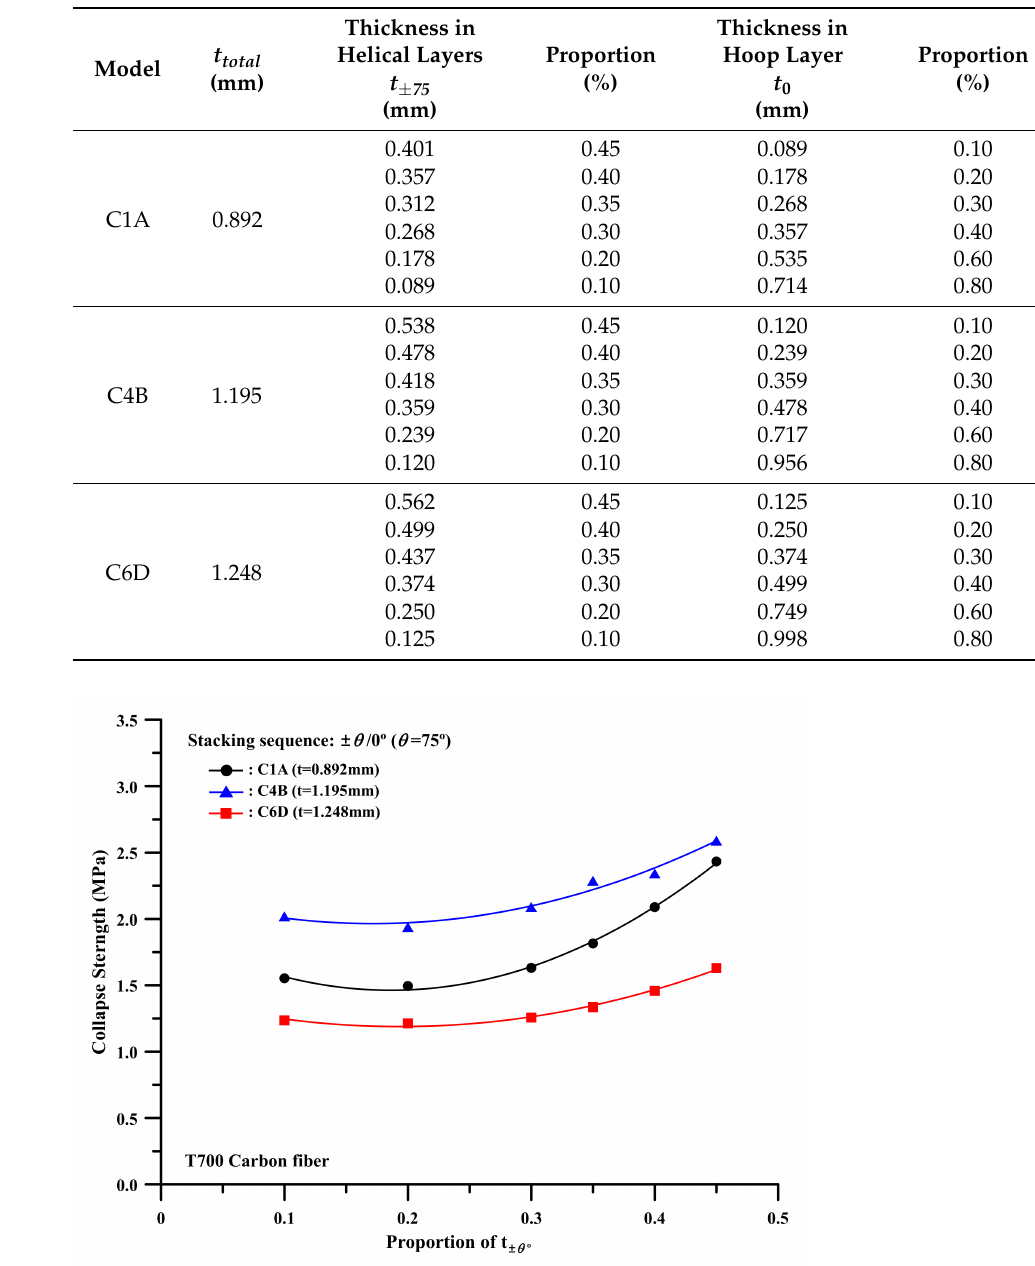
Figure 14. Three models with different thickness portion in helical layers ( ± 75/0